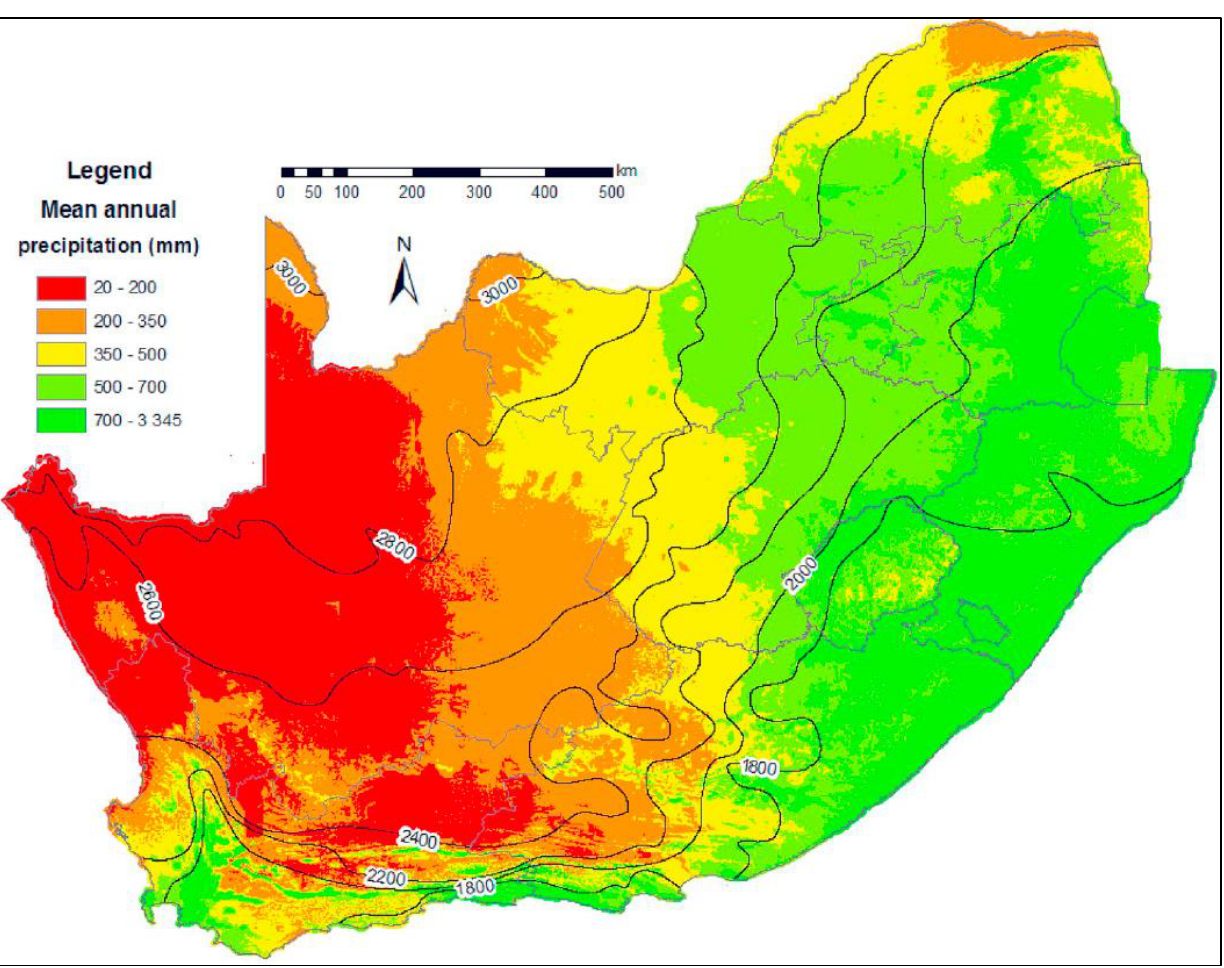
Figure 2. Mean annual precipitation and mean annual potential evapotranspiration isohyets (mm) in South Africa [25].